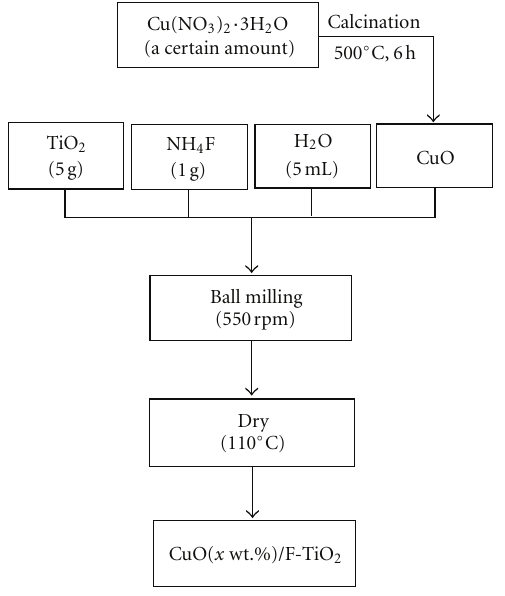
Scheme 1: The flow chart of preparation of the CuO/F-TiO 2 .